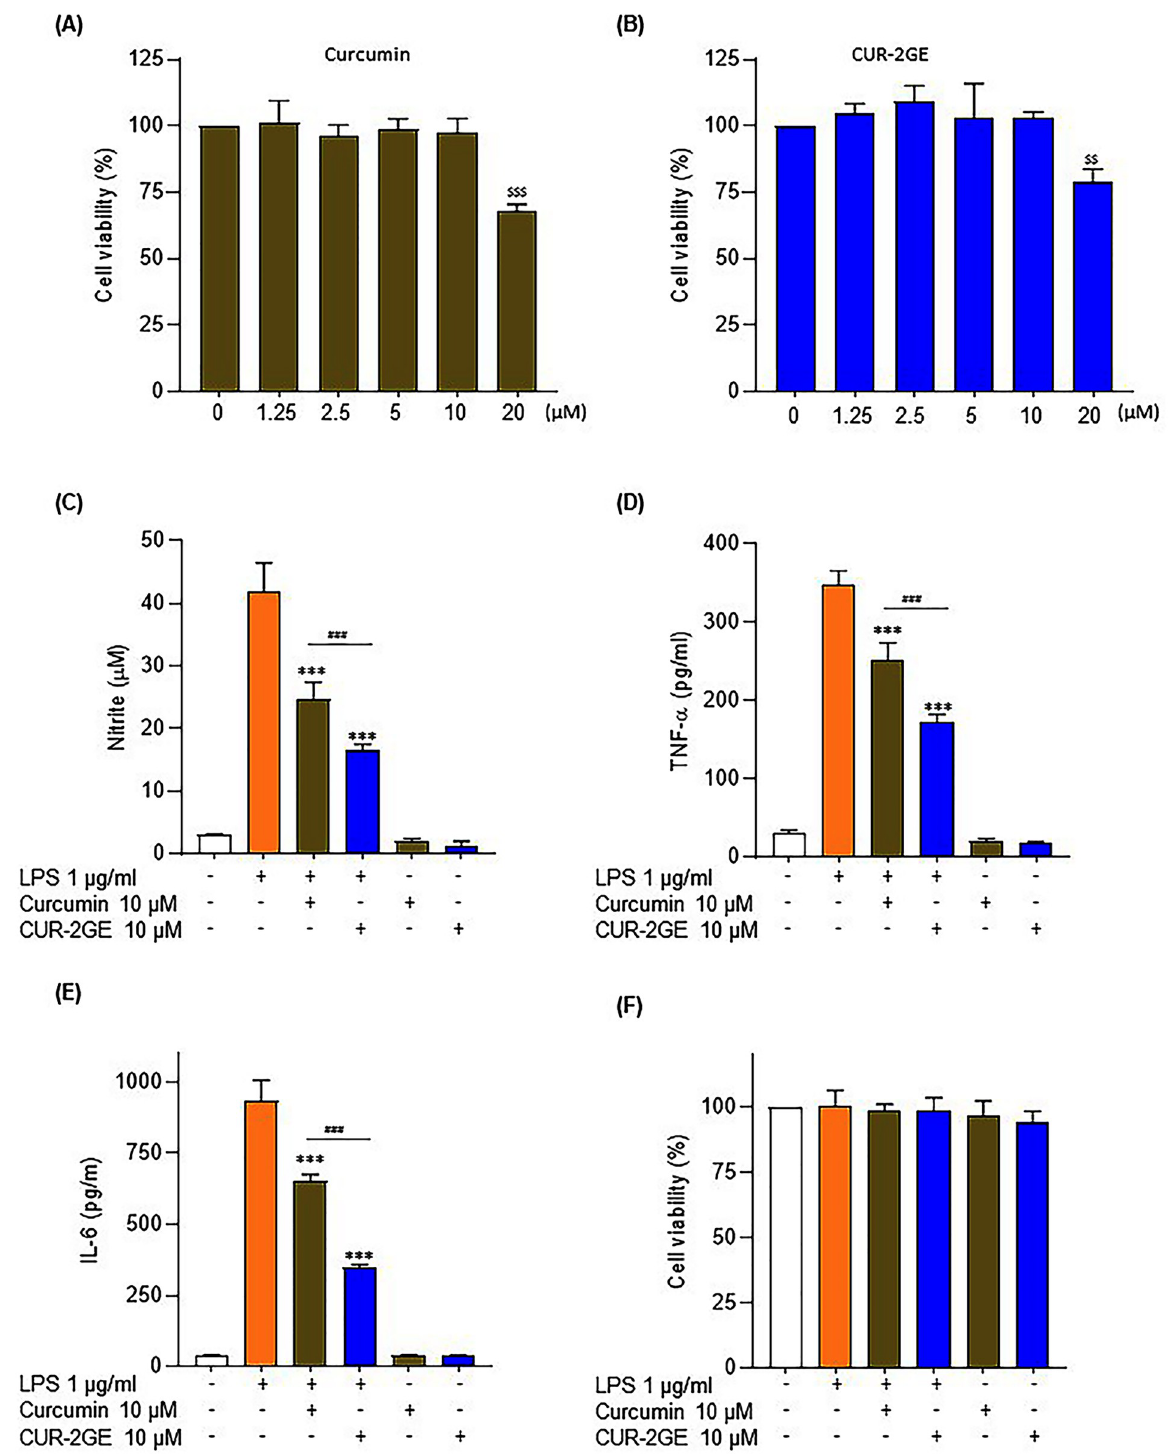
Fig 9. Effects of curcumin and Cur-2GE on cytotoxicity and secretion of pro-inflammatory mediators in LPS-stimulated BV-2 microglial cells. (A-B) Cytotoxicity, (C) NO, (D) TNF- α , (E) IL-6 and (F) Cell viability. Data are expressed as mean ± SD of three independent experiments. $ $p < 0.01, $$ $p < 0.001 compared to the control group. ��� p < 0.001 compared to the LPS group. ###p < 0.001 significant difference between curcumin and CUR-2GE groups. The differences were analyzed by one-way ANOVA followed by the Bonferroni post hoc test.